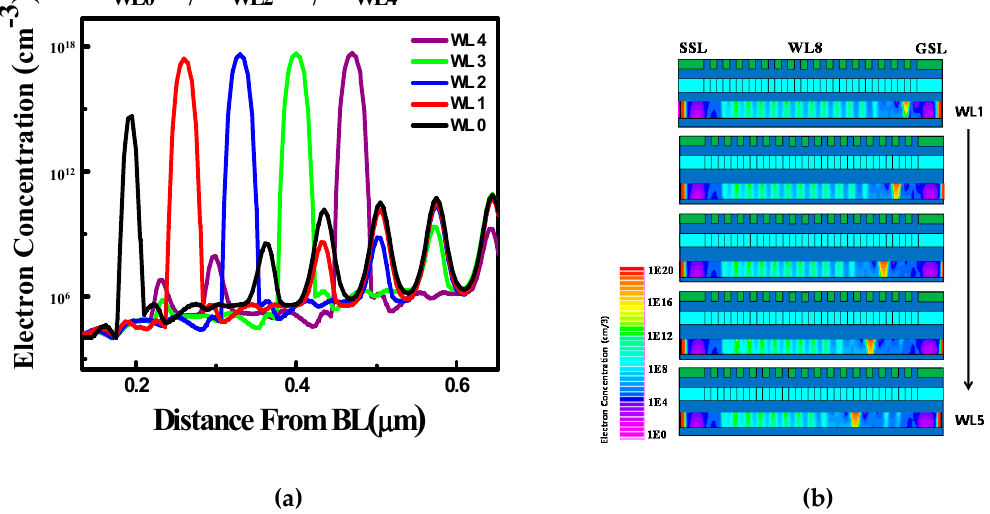
Figure 5. Electron concentration of the 3D NAND channel when V PGM reaches 18V ( a ) electron concentration of each WL and ( b ) electron concentration profile of the channel in the real simulation device.